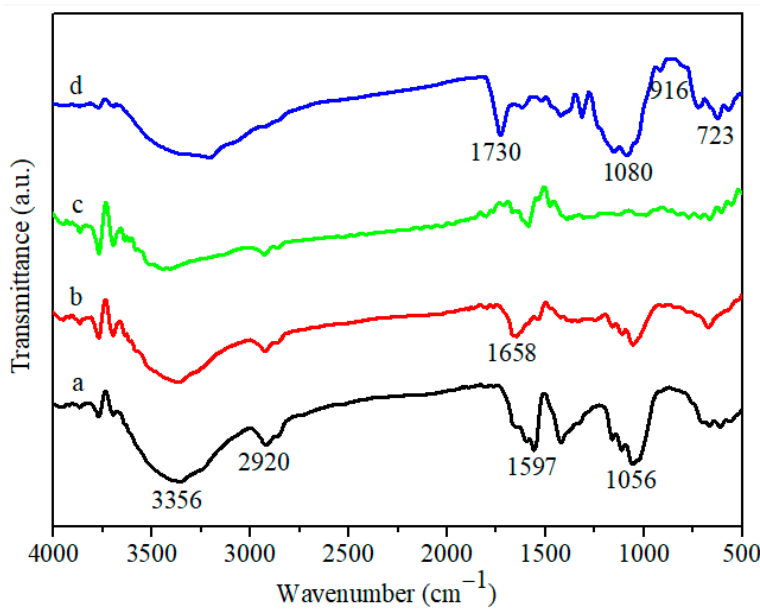
Figure 2. FT-IR spectra of (a): BC; (b): GOBC; (c): rGBC; and (d): Pc-rGBC.